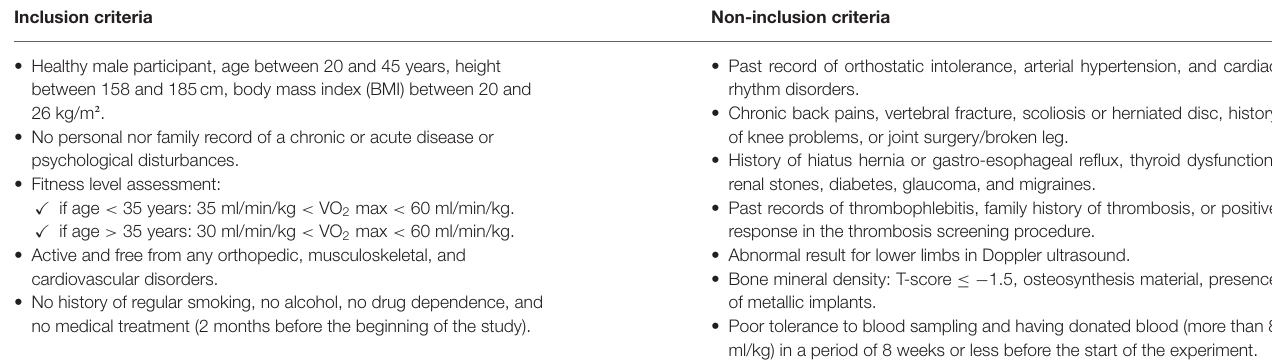
TABLE 1 | Inclusion and non-inclusion criteria.